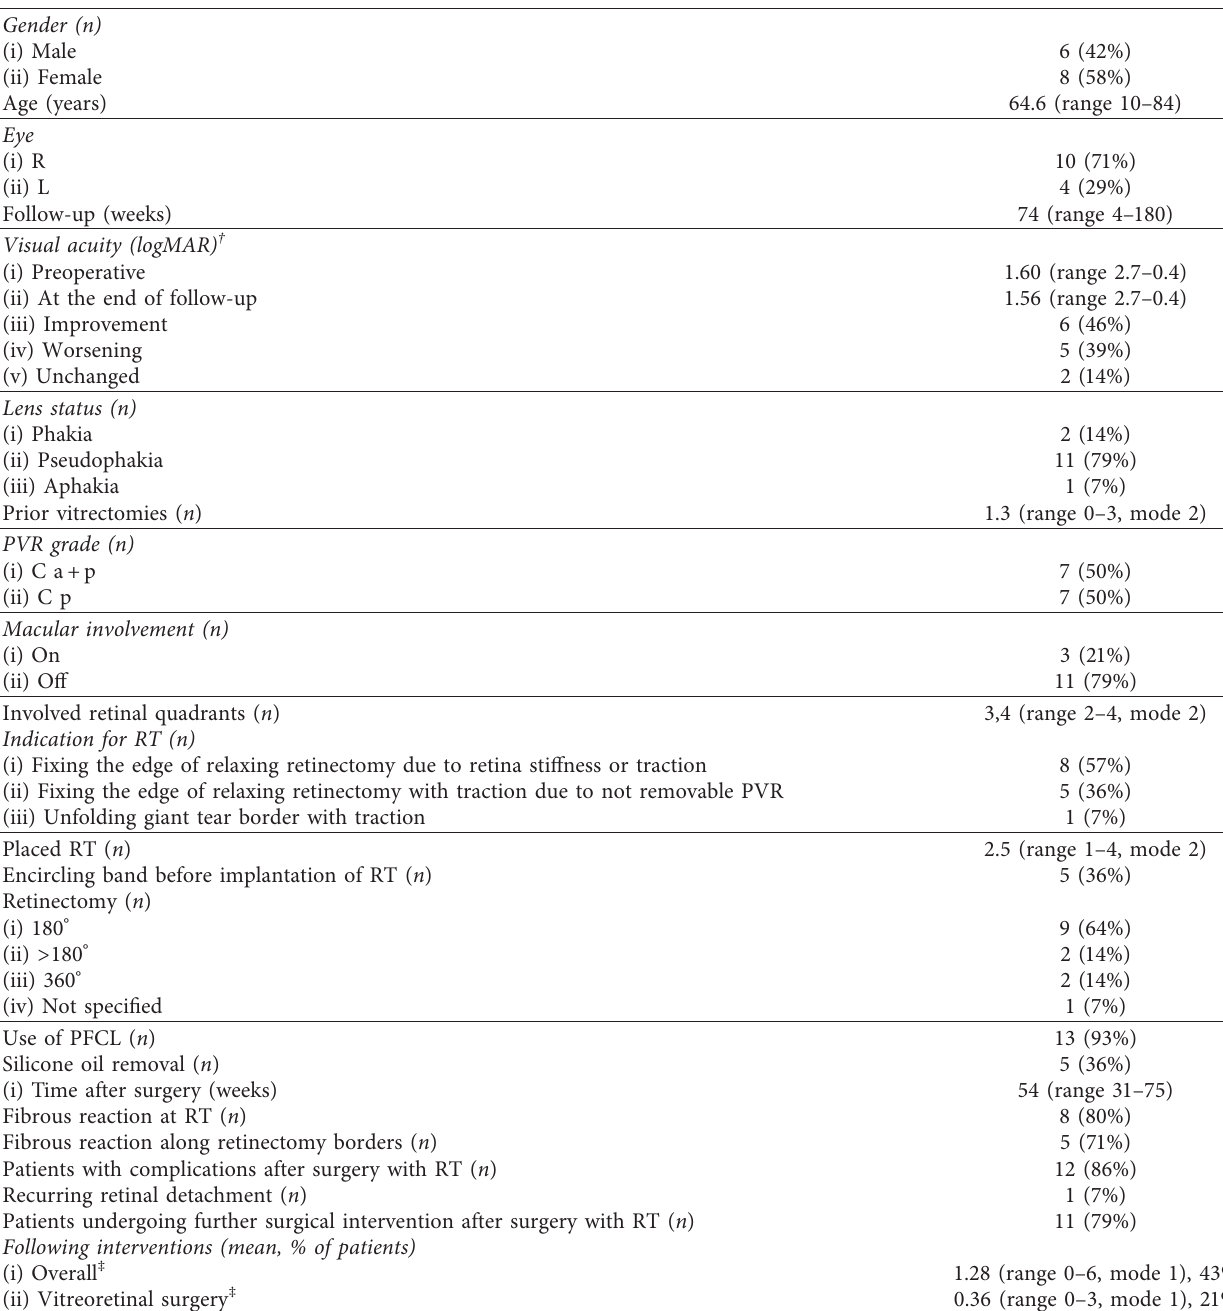
Table 1: Patients’ surgery